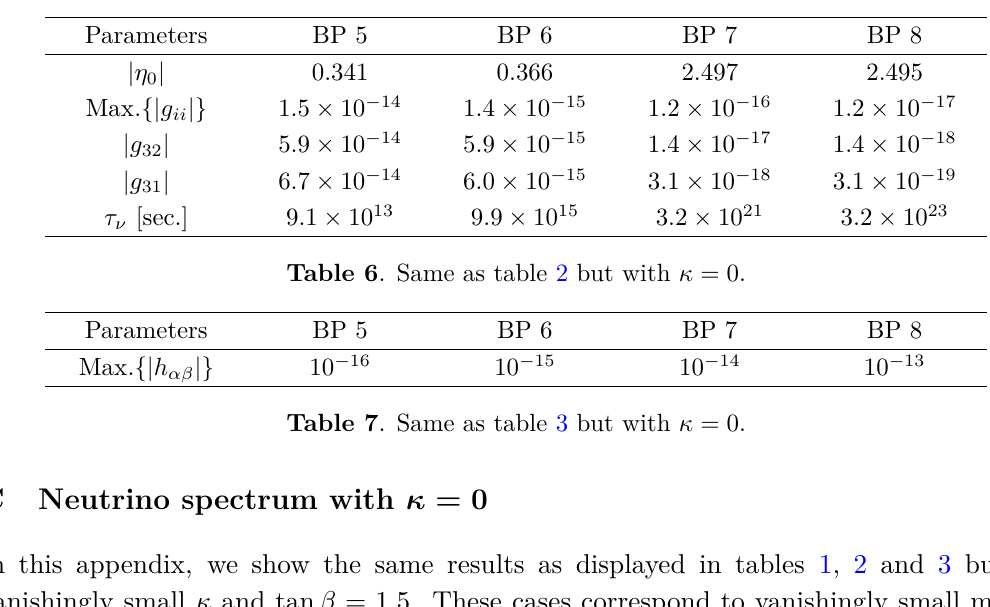
Table 5 . Same as table 1 but with κ = 0 .